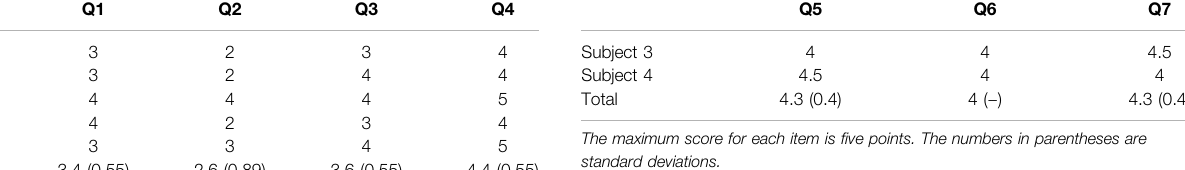
TABLE 4 | Questionnaire results from fi ve experts. Q1